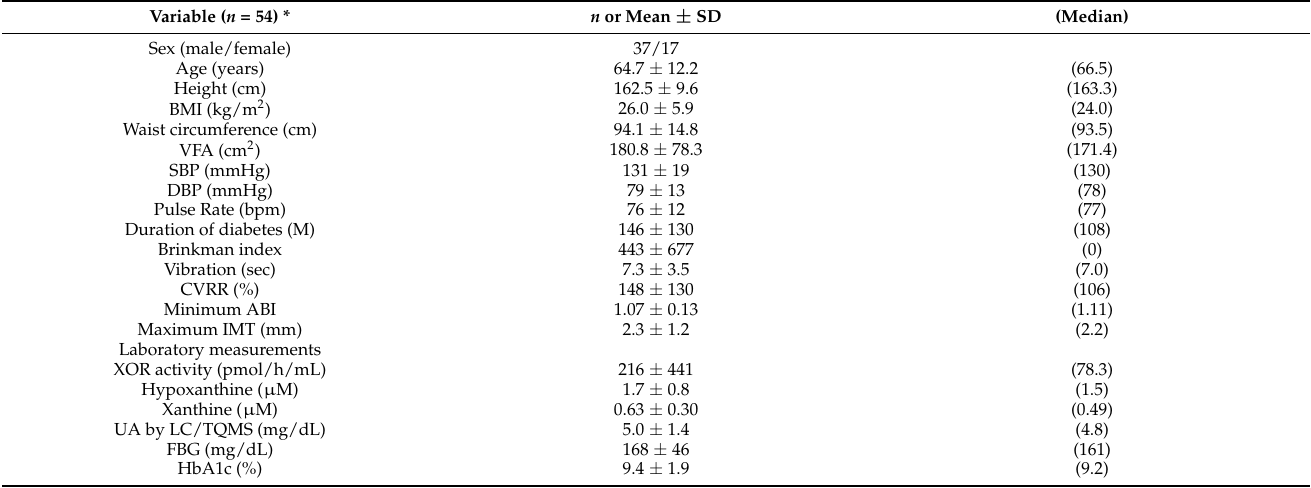
Table 1. Baseline characteristics of study